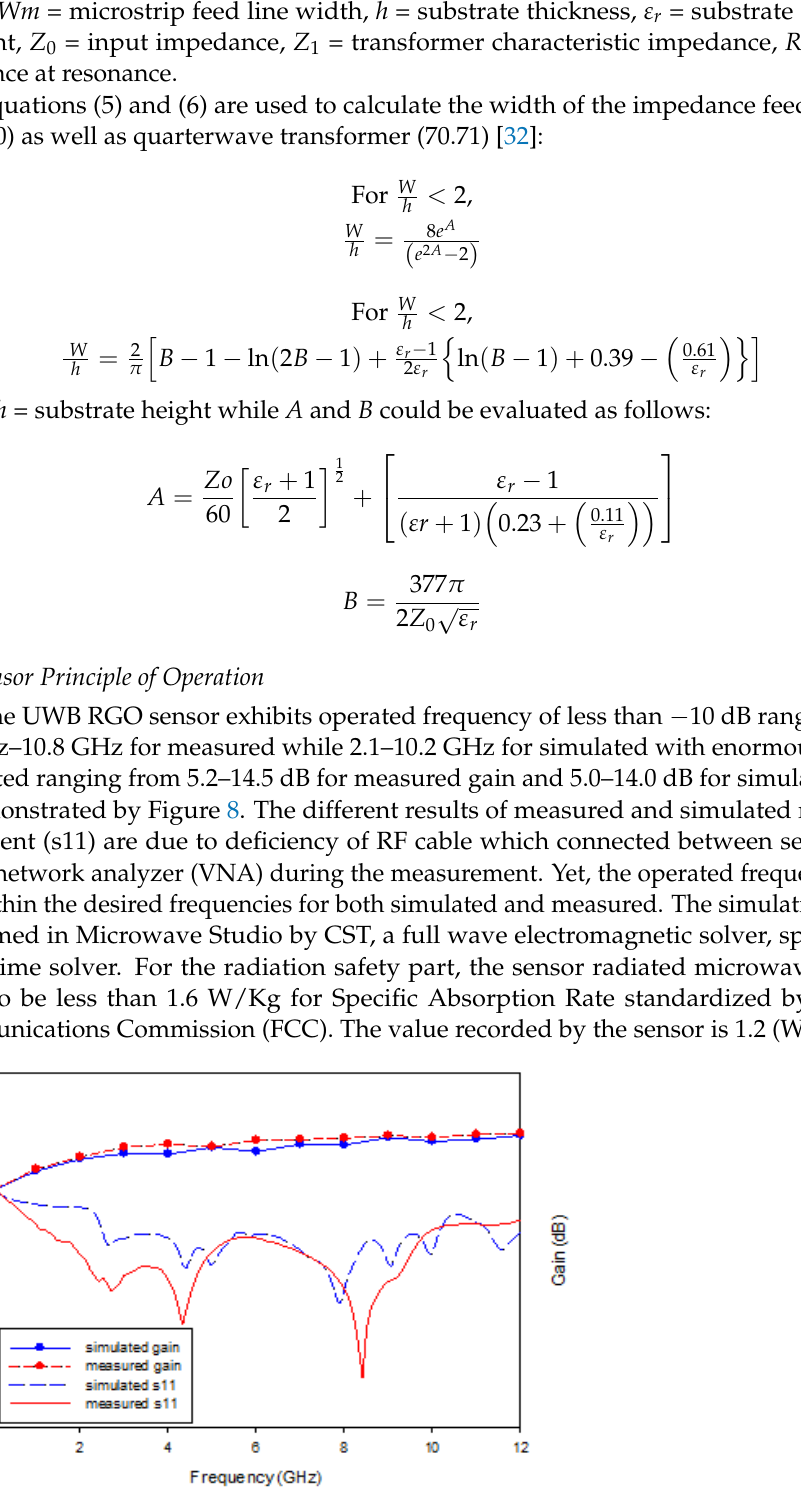
Figure 8. S11 result with gain for the sensor.